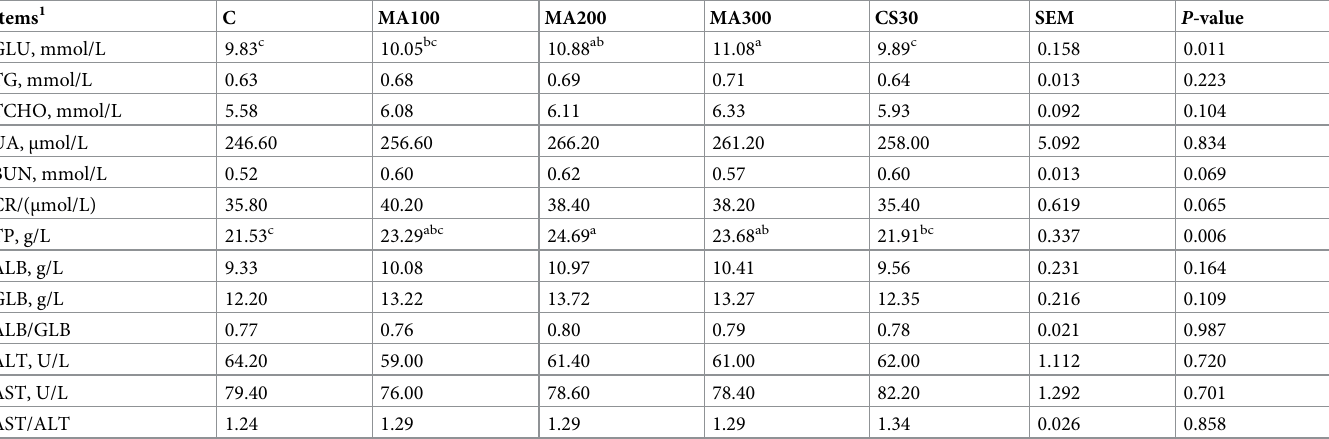
Table 5. Effect of different magnolol levels in diet on serum biochemical indices of 28 d Linwu ducks. Items